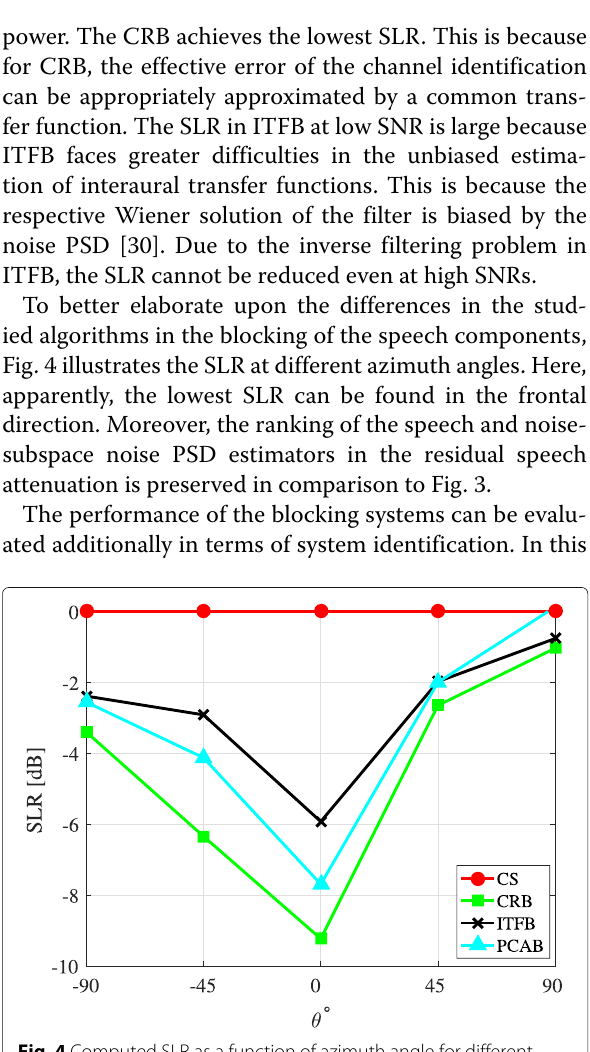
Fig. 3 SLR as a function of SNR for different algorithms, θ = − 45 ◦